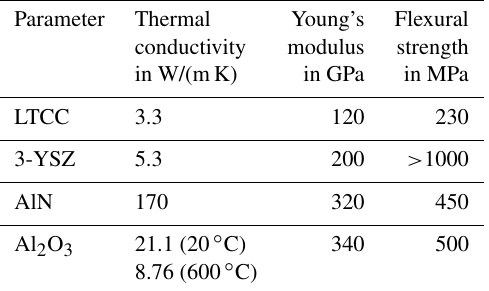
Table 1. Comparison of the mechanical and thermal properties of different commercially available substrate materials. Parame- ters were taken from the manufacturers’ data sheets and literature (DuPont, 2011; KERAFOL Keramische Folien GmbH & Co. KG, 2020; MARUWA Co., Ltd., 2019; Verband der Keramischen Indus- trie e.V., 1999). The thermal conductivity for Al 2 O 3 is calculated from Kita et al. (2015). Parameter Thermal Young’s Flexural conductivity modulus strength in W/(mK) in GPa in MPa LTCC 3.3 120 230